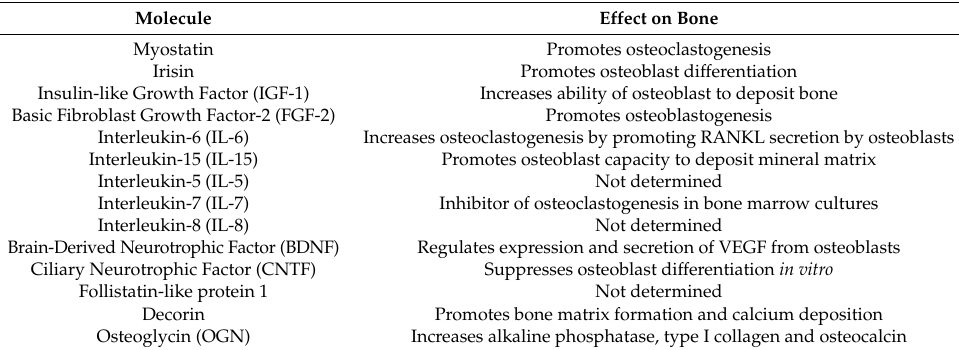
Table 1. Myokines known to date, and their effects on bone.